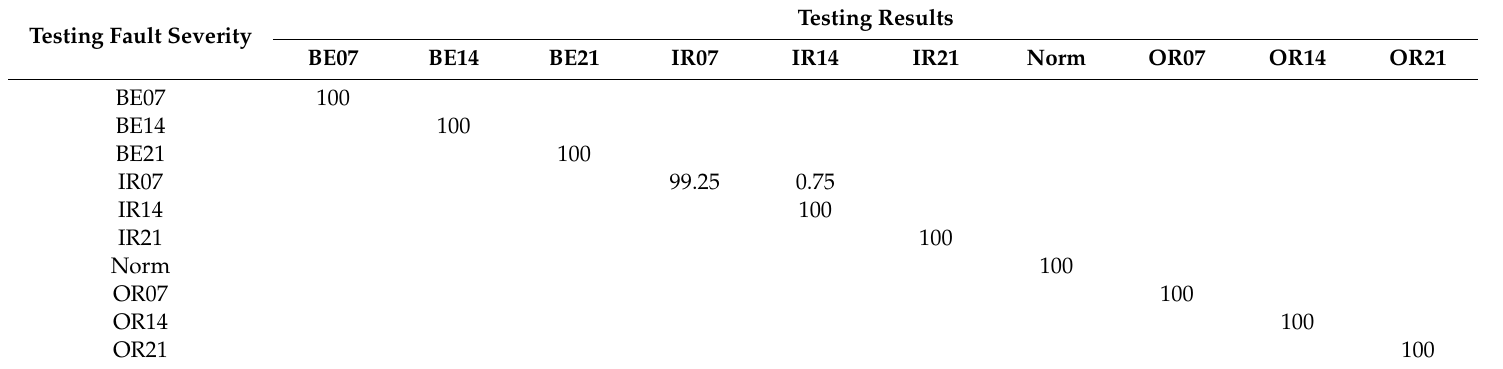
Table 11. Fault identification accuracy of the mRVM 1 _conv 1 under di ff erent fault severity with the load 0 hp (%).